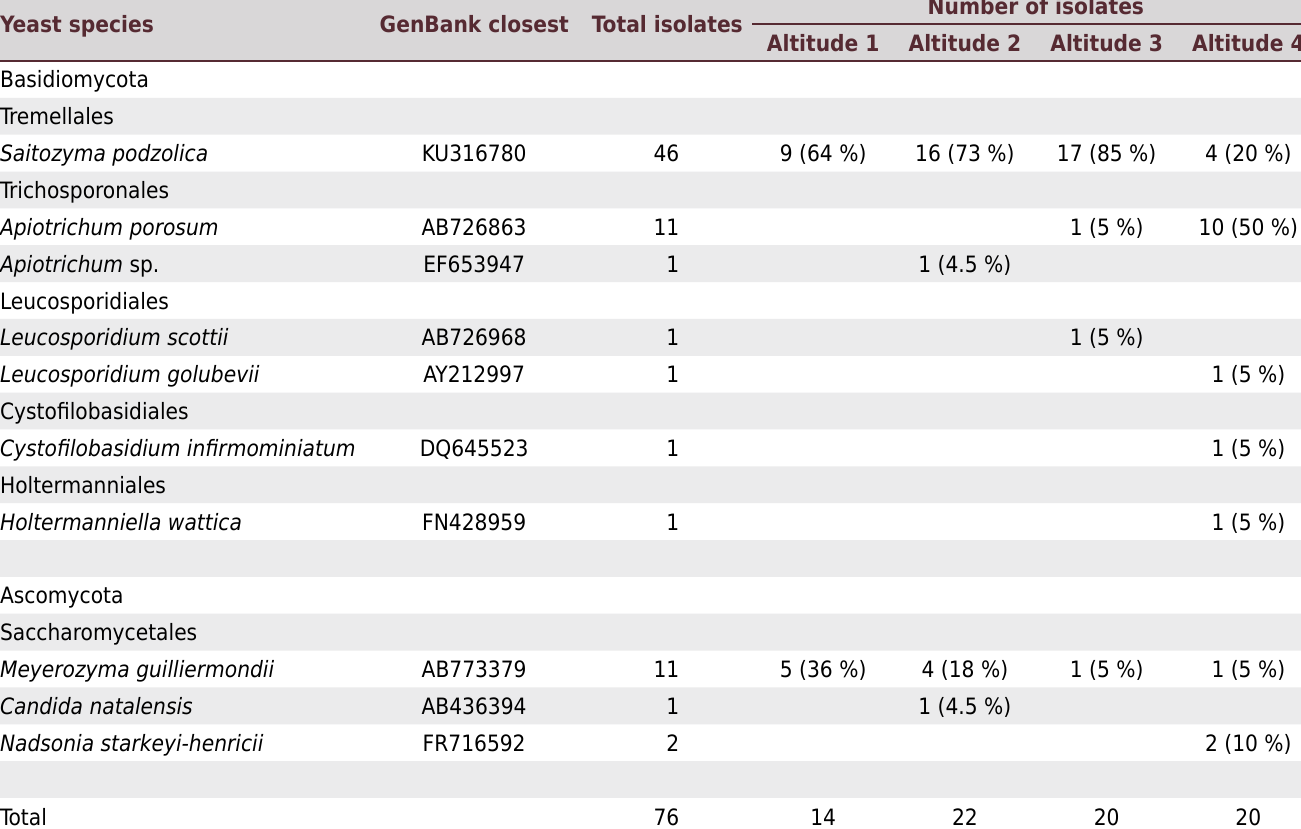
Table 1. Inventory and occurrence frequency (%) of yeast species isolated at four altitudes in the PARNASO, Rio de Janeiro, Brazil Yeast species GenBank closest Total